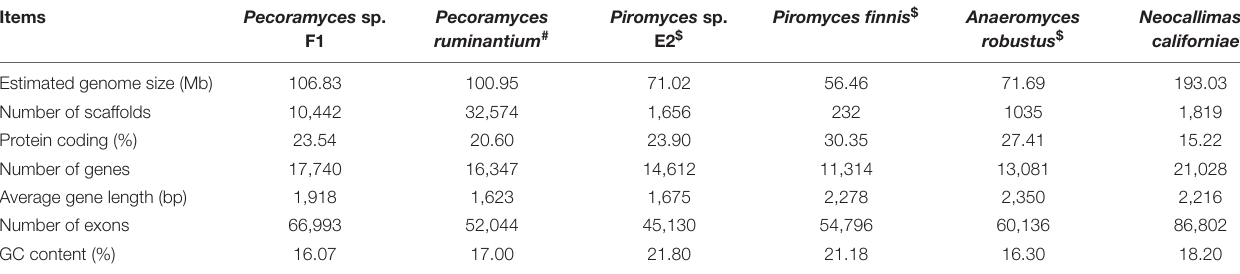
TABLE 2 | A comparison of genomes of Pecoramyces sp. F1 and other anaerobic fungi.